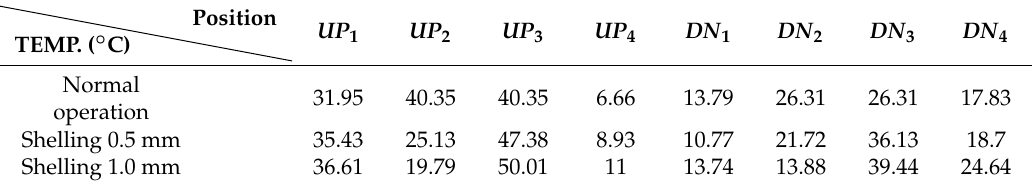
Table 2. The calculation results of the stator insulation temperature